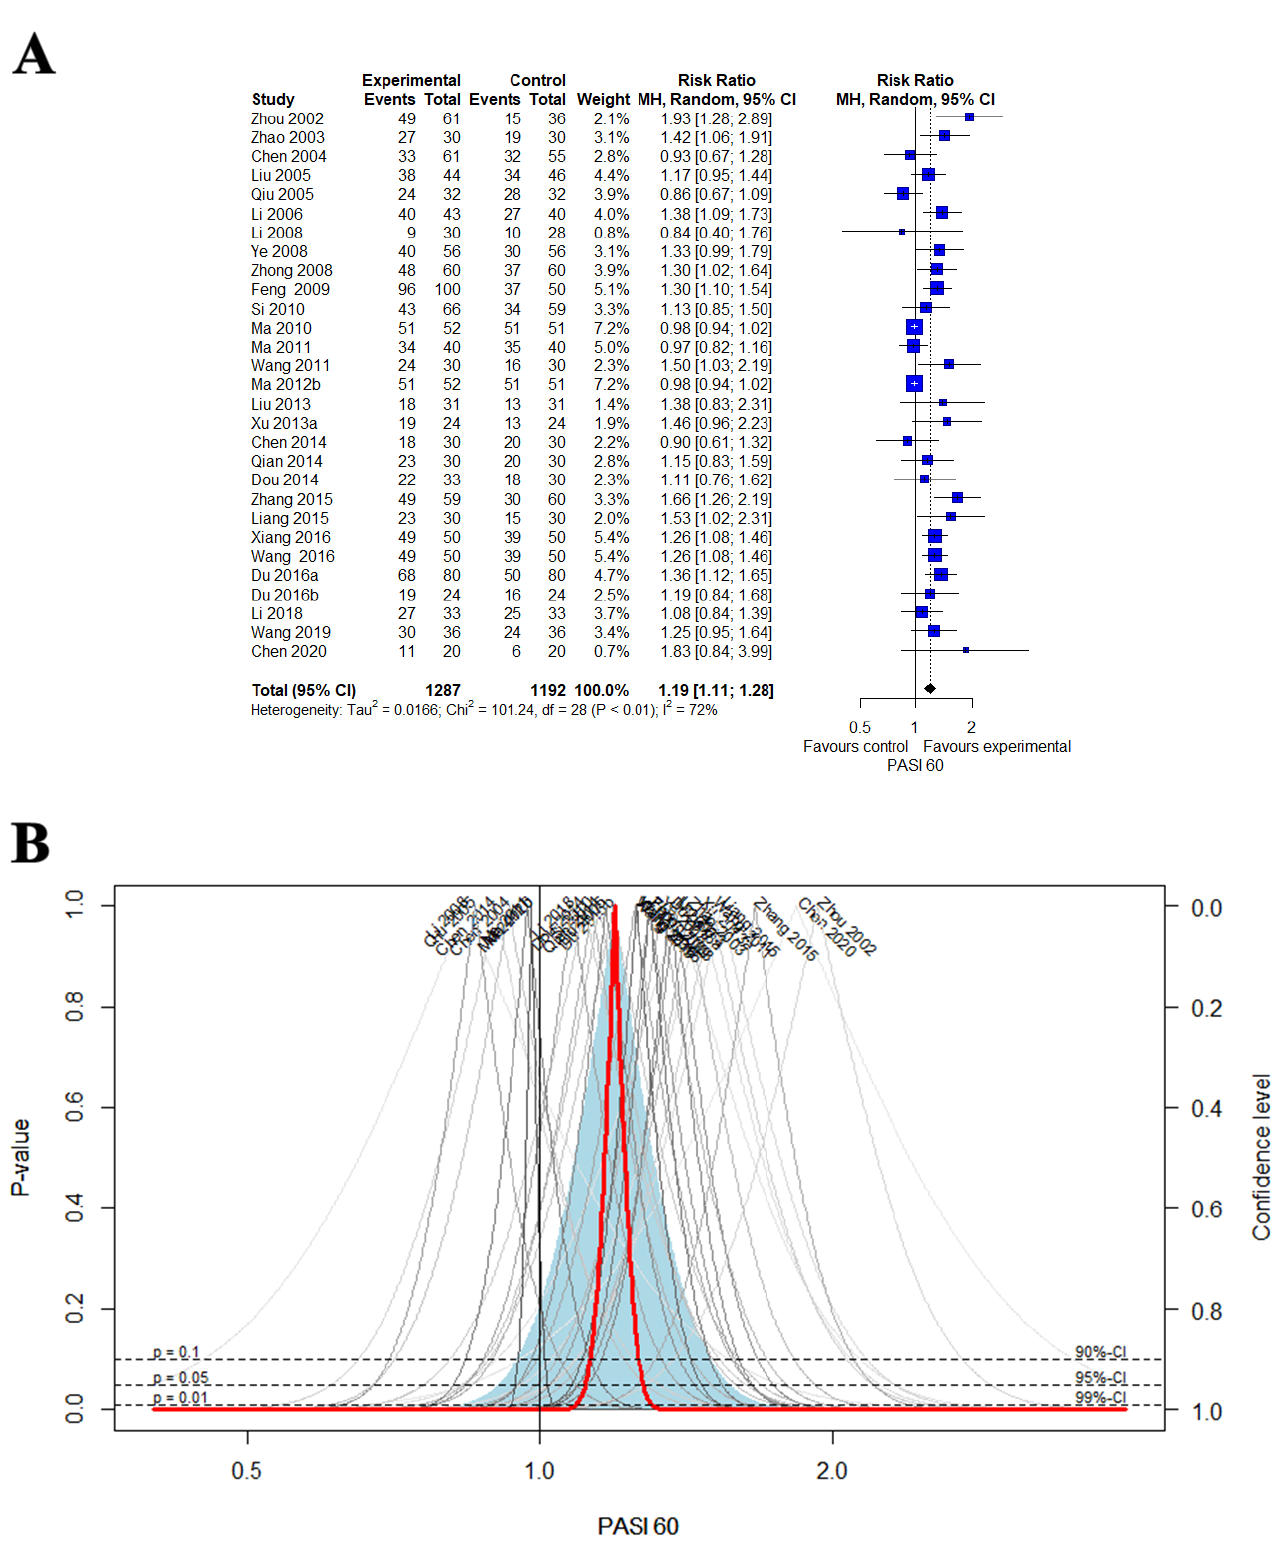
Figure 3. ( A ) Forest plot of the trials that compared EAHM with CM for PASI 60; ( B ) drapery plot of the trials that compared EAHM with CM for PASI 60.